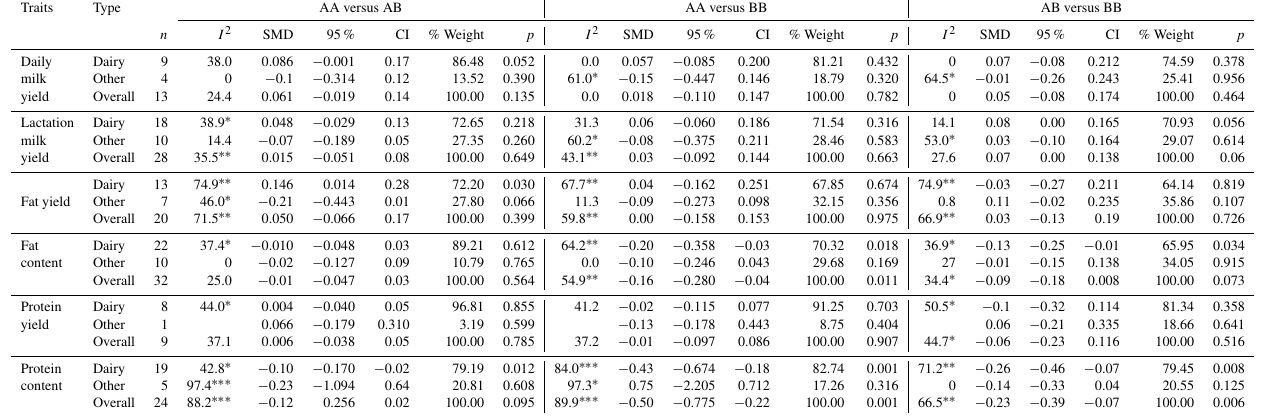
Table 2. Results of the meta-analysis on associations among CSN3 genotypes and milk production traits, SMD values, and level of signifi-